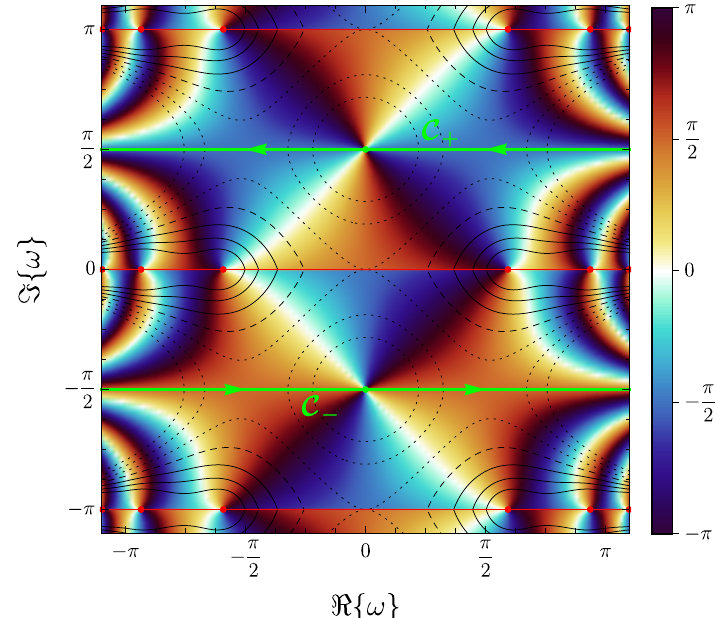
Figure 5: Complex structure of the integrand of (4.27). The two contours C + in the upper and C − in the lower half-plane are connected by non-contributing paths at ℜ{ ω } → ±∞ to form the closed contour C . The complex phase is colour coded from − π to π , while the lines of constant absolute value c are shown as black dotted ( c < 1), dashed ( c = 1) or solid ( c > 1) lines ranging from 2 − 3 to 2 + 3 . The zeros at ω = ± i π/ 2 are marked as green dots, while the poles on the lines with ℑ{ ω } = n π , n ∈ (cid:90) , are marked as red dots. Additionally, the phase jump due to the different choices for the counting polynomial for the upper and lower half-plane are marked as red lines. Note that due to the transformation into the hyperbolic ω -plane the structure is 2 π -periodic along the imaginary axis. The contributions along the paths C + and C − are equal, as the phase in the upper half-period is reversed with respect to the lower